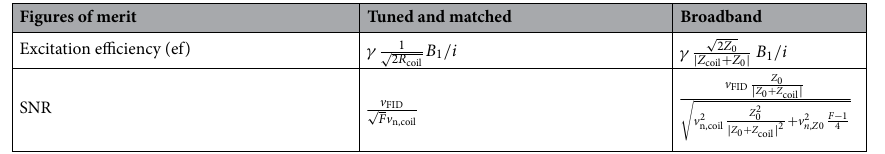
Table 1. NMR figures of merit for two different working regimes, applicable to a conventional tuned/matched coil, and a broadband coil. In all four cases, the figure of merit should be maximised in order to have the best